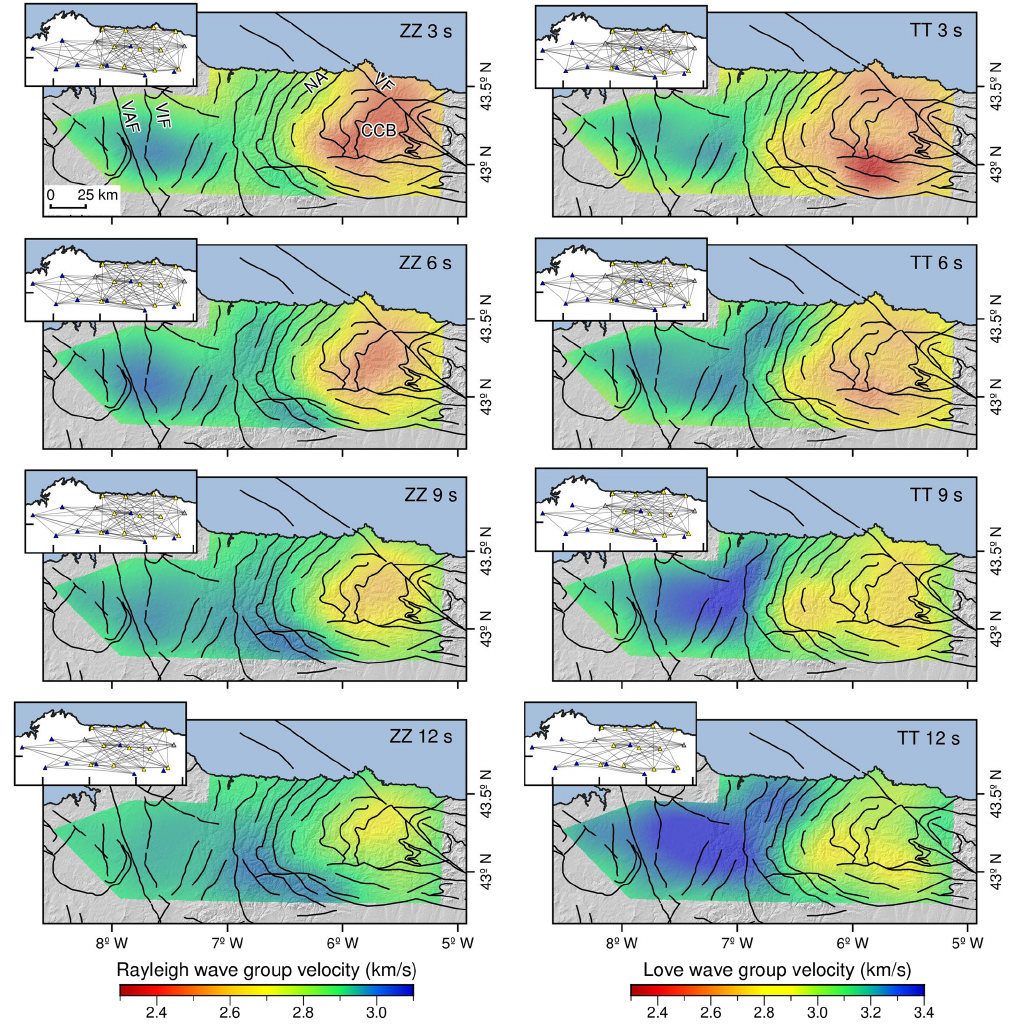
Figure 4. Rayleigh (left panels) and Love (right panels) group velocity tomographic maps for 3, 6, 9, and 12s periods. Black lines represent the main Alpine and Variscan faults. Insets depict the interstation paths used in each inversion. CCB: Central Coal Basin, NA: Narcea antiform, VF: Ventaniella fault, VIF: Vivero fault, VAF: Valdoviño